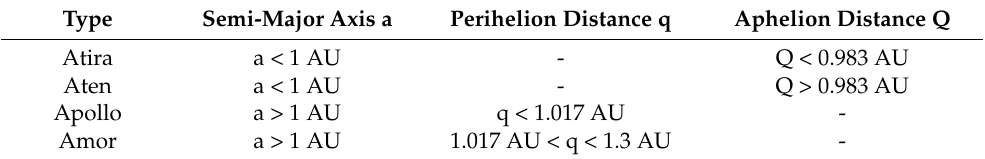
Table 1. Classification of Near-Earth Asteroids.